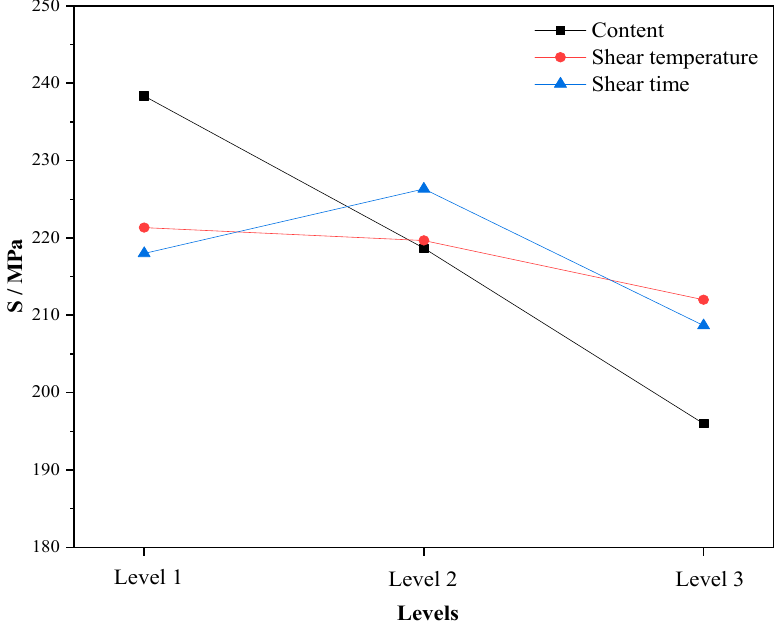
Figure 5. The variation of the mean S with the levels.